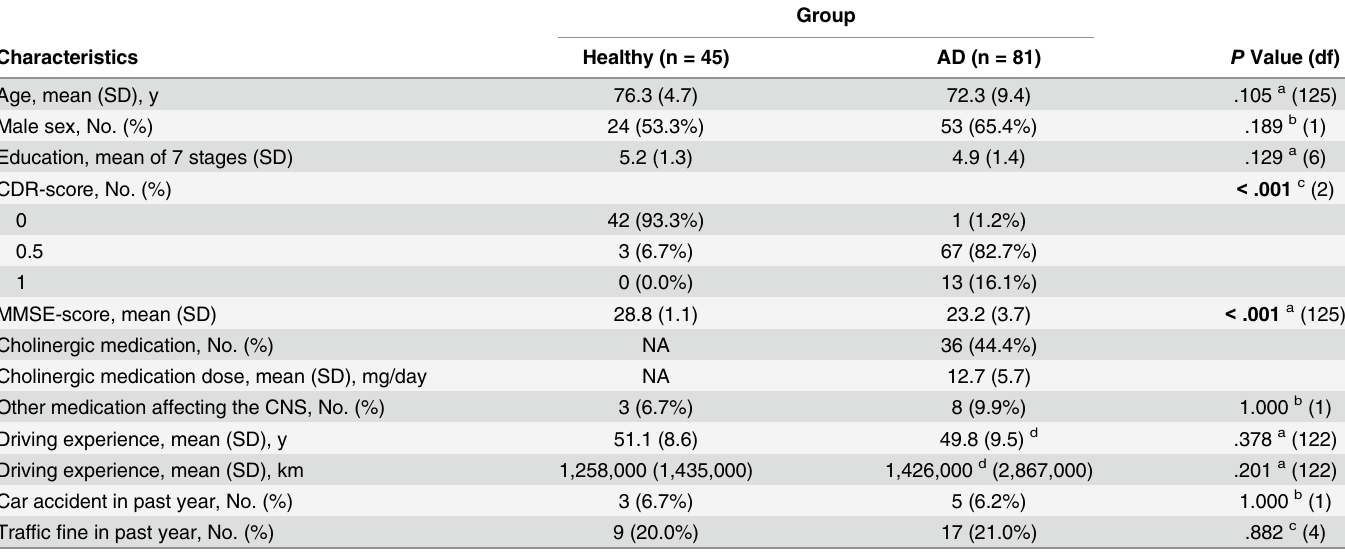
Table 1. Characteristics of healthy participants and patients with Alzheimer ’ s